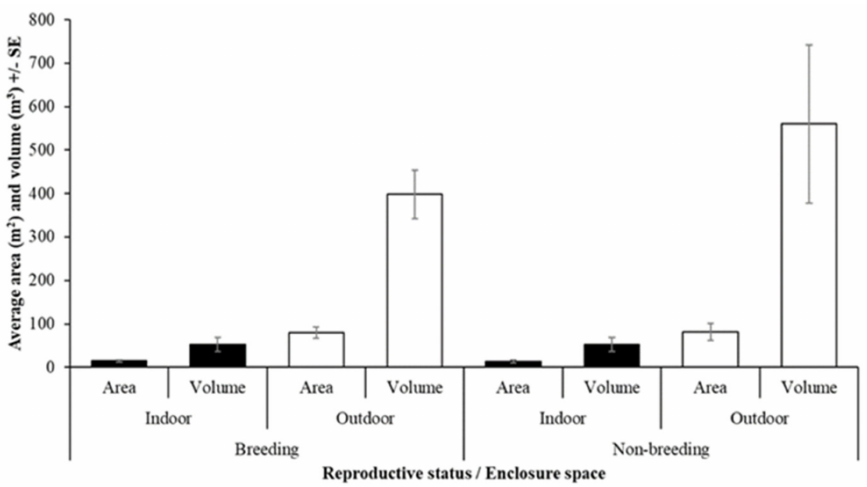
Figure 6. Comparison of mean indoor and outdoor area and volume for breeding and non-breeding fossa in this sample of